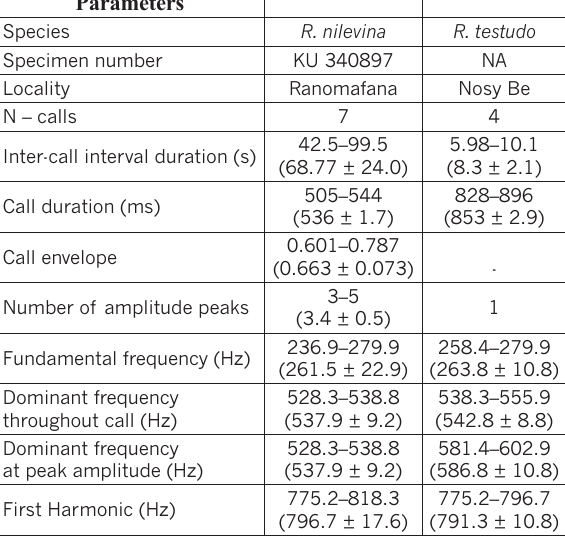
Table 3. The advertisement call recorded for Rhombophryne ni- levina in comparison with that of R. testudo . Calls were record- ed from males calling during the day that were subsequently collected as vouchers. Note envelope is the ratio of the time of peak amplitude to note duration. Data are the range and then the mean ± two standard deviations in parentheses, when appropri- ate. The call recording of R. testudo is from Vences et al .